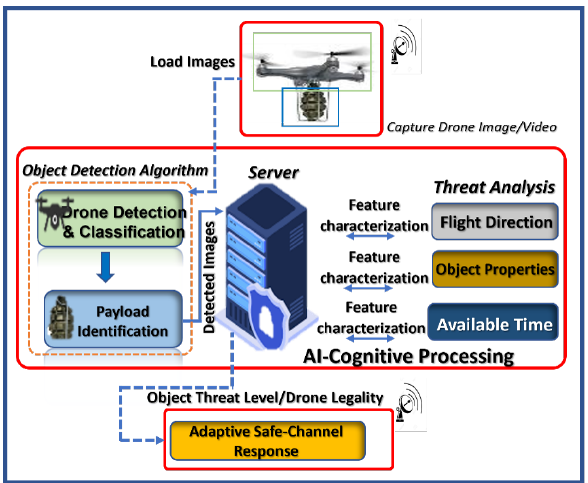
Figure 1. Architecture of collaborative cognitive invasive encroachment scheme highlighting the detection and classification, identification and unique recognition, threat analysis, and situation-aware neutralization